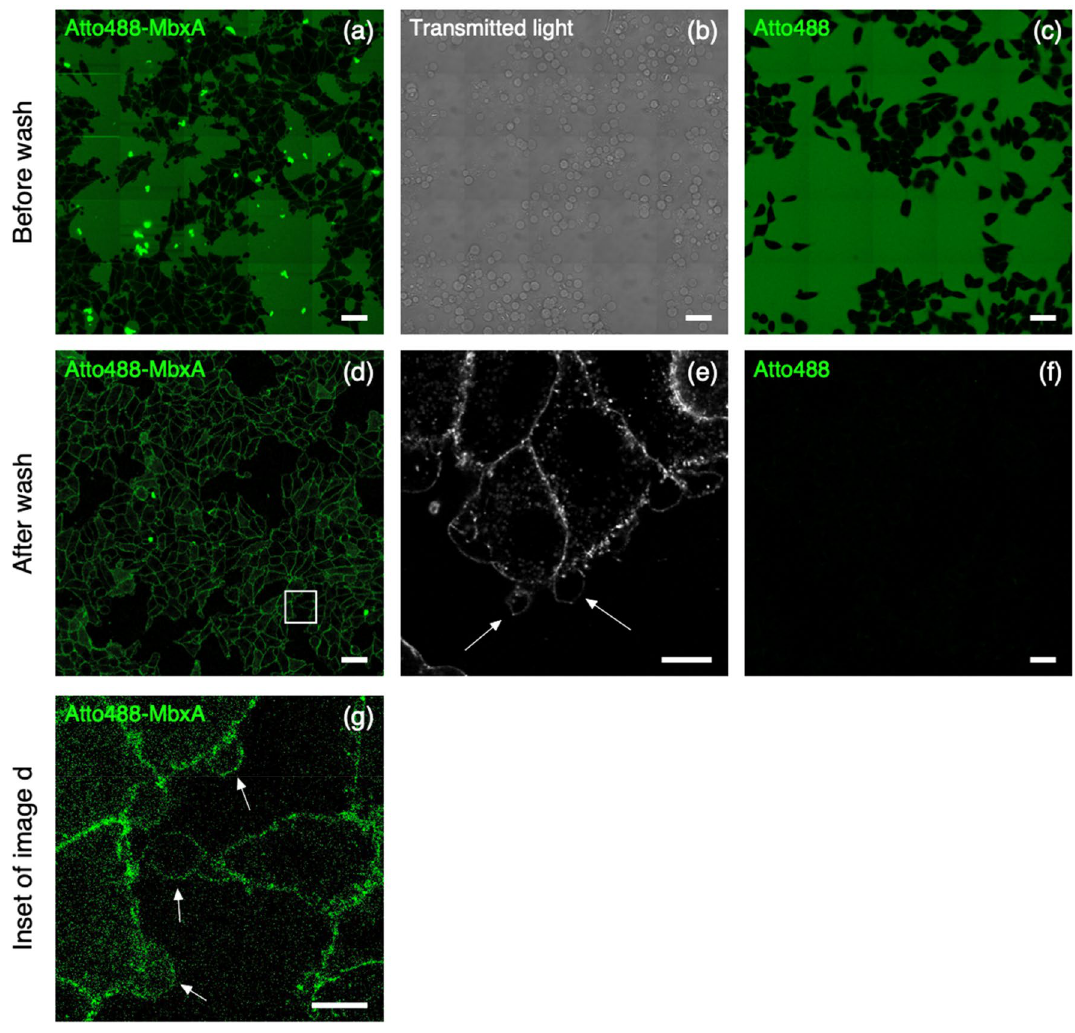
Figure 11. Incubation experiment of Atto488-MbxA S9C with HEp-2 cells. HEp-2 cells after 30 min of incubation with 250 nM Atto488-MbxA S9C , before ( a and b ) and after ( d and e ) removing excess unbound Atto488-MbxA S9C . Confocal overview images of fluorescent signal are shown in ( a ) and ( d ), transmitted light showing formation of blebbing process in ( b ) and super-resolution Airyscan micrograph in ( e ). Accumulations of Atto488-MbxA S9C tracing the outline of HEp-2 cells are clearly visible after removing the unbound Atto488- MbxA S9C ( d ). Control experiment with Atto488 (dye used to label MbxA) is shown in ( c ) and ( f ). HEp-2 cells after 30 min of incubation with Atto488, before ( c ) and after ( f ) washing off the unbound Atto488 from surrounding medium. The control experiment confirmed that accumulations tracing the outline of HEp-2 cells in ( d ) and ( e ) are Atto488-MbxA S9C , not the free dye. White arrows indicate the position of membrane blebs. ( g ) Zoom into white square in panel ( d ). Scale bars: a , b , c , d , f : 50 µm; e : 10